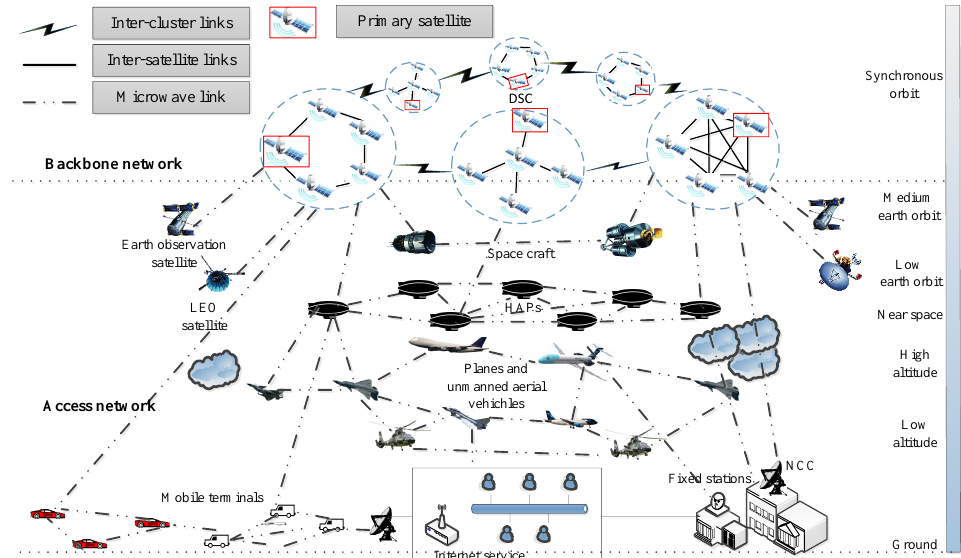
Figure 1. The SIN architecture based on